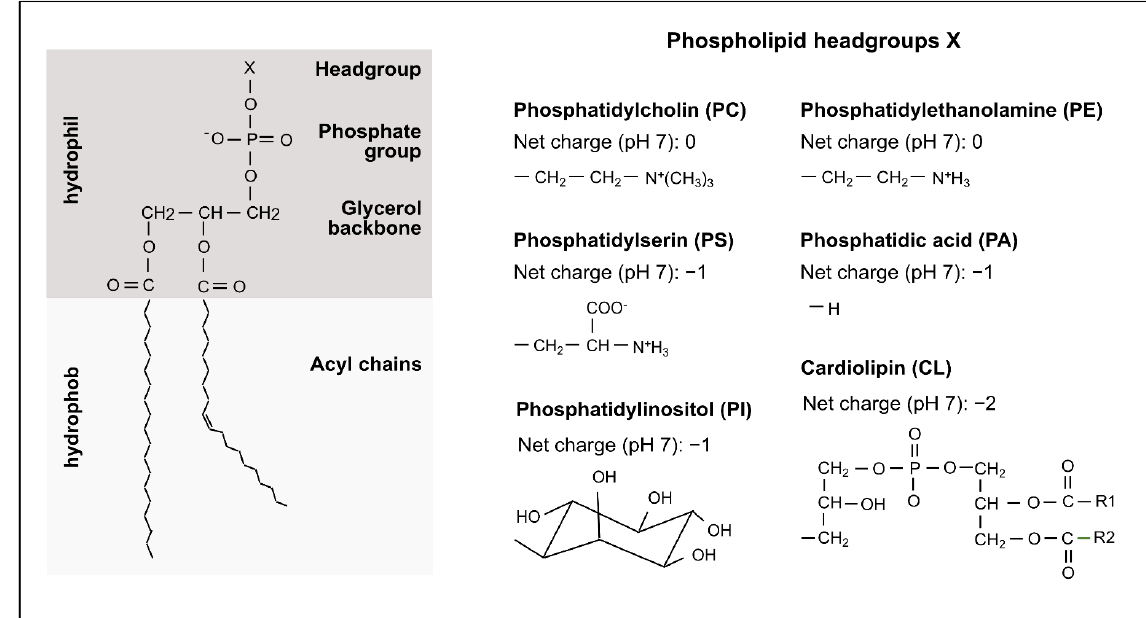
Figure 1. Mitochondrial phospholipids. Phospholipids contain a hydrophilic head with a glycerol backbone as the central structural element and distinct headgroups, each linked by a phosphate group. The headgroup is characteristic for each class of phospholipids: phosphatidylcholine (PC), phosphatidylethanolamine (PE), phosphatidylinositol (PI), phosphatidylserine (PS), phosphatidic acid (PA) and cardiolipin (CL). It varies in its net charge and is linked via a phosphate group to glycerol. Acyl chains are also attached to the glycerol backbone via ester bonds and form the hydrophobic tail of the phospholipids. The acyl chains can vary in length and saturation. Figure 1 is adapted from [19].